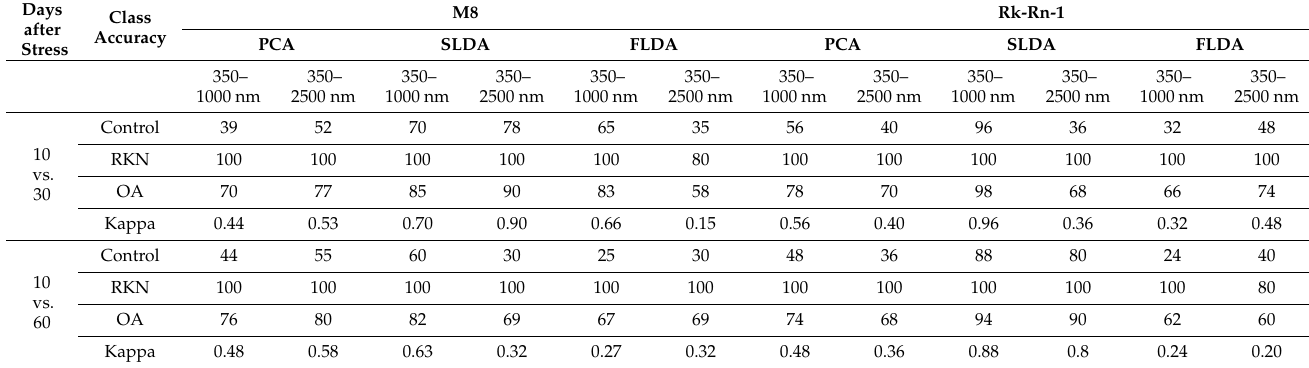
Table 4. Temporal misalignments in a two-class problem (M8 vs. Rk-Rn-1) using leaf spectral reflectance information between 350–1000 nm and 350–2500 nm of cotton genotypes measured at 10, 30, and 60 days after stress treatment in